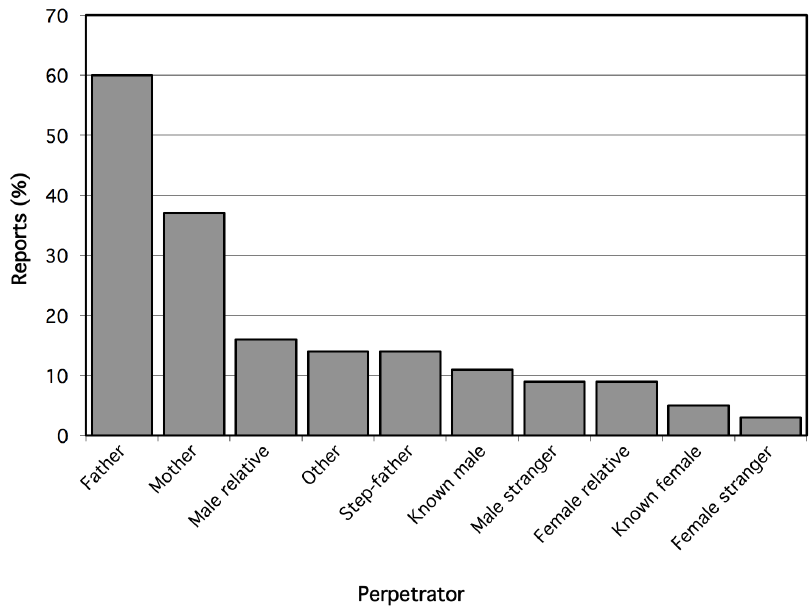
Figure 2. Perpetrators of childhood physical abuse reported by young HIV-negative gay and bisexual men in Vancouver, Canada (n=287). Table 1 describes factors associated with CPA among study